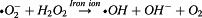
The proposal reaction of caffeic acid and ABTS ·+.